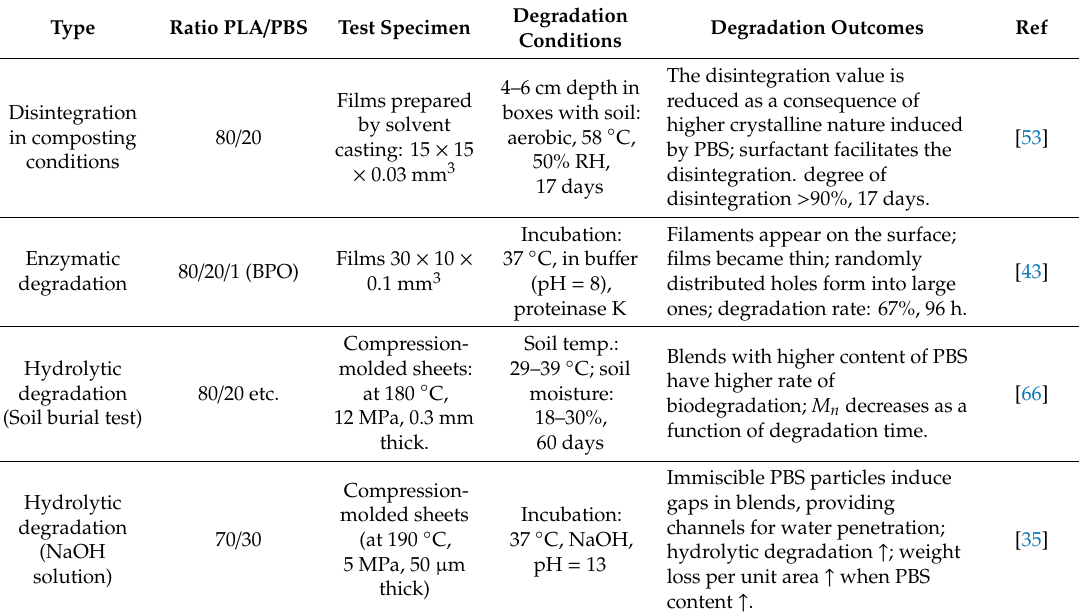
Table 6. Biodegradation and disintegration of PLA / PBS